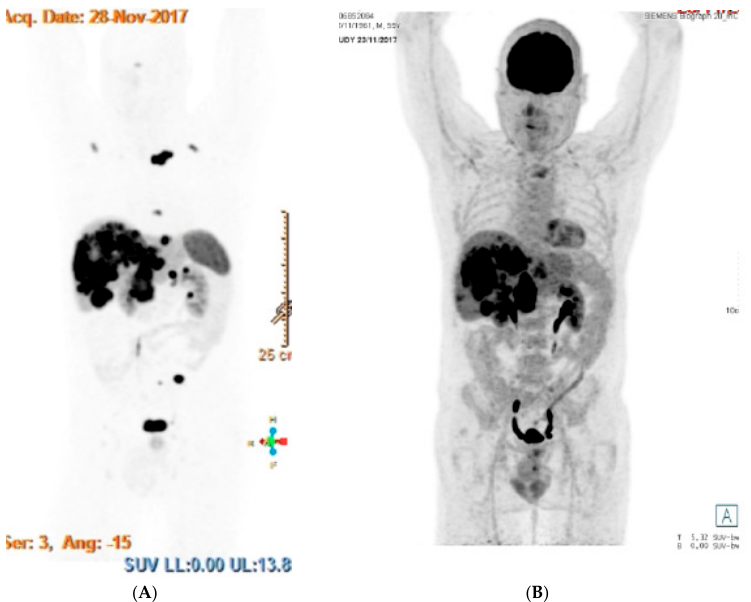
Figure 1. Functional imaging for a patient with metastatic pancreatic grade 3 neuroendocrine tumor (NET G − 3). ( A ) Images of DOTATOC-PET on the left and ( B ) FDG-PET on the right showing both positive uptakes in the liver, lungs and nodes.